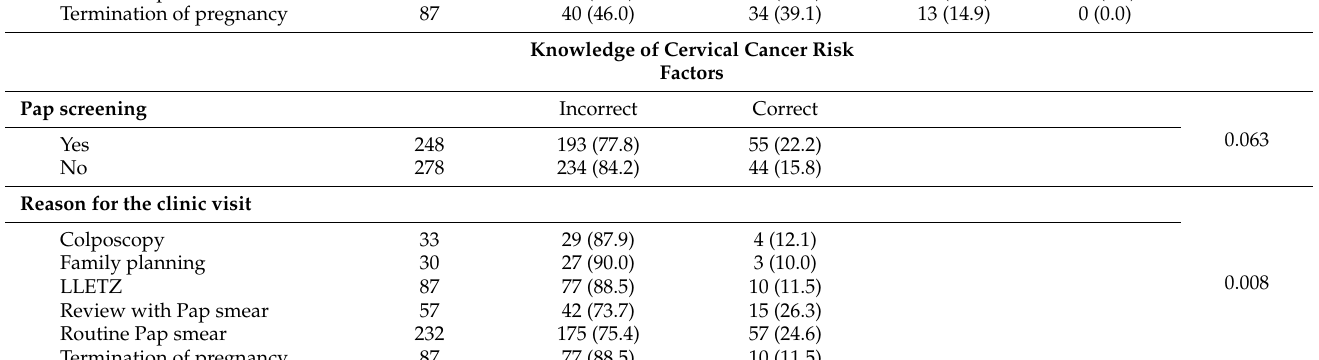
Table 3. Knowledge of HPV and cervical cancer risk factors by Pap screening and reason for the clinic visit. Knowledge of HPV n Good No Knowledge Fair Knowledge